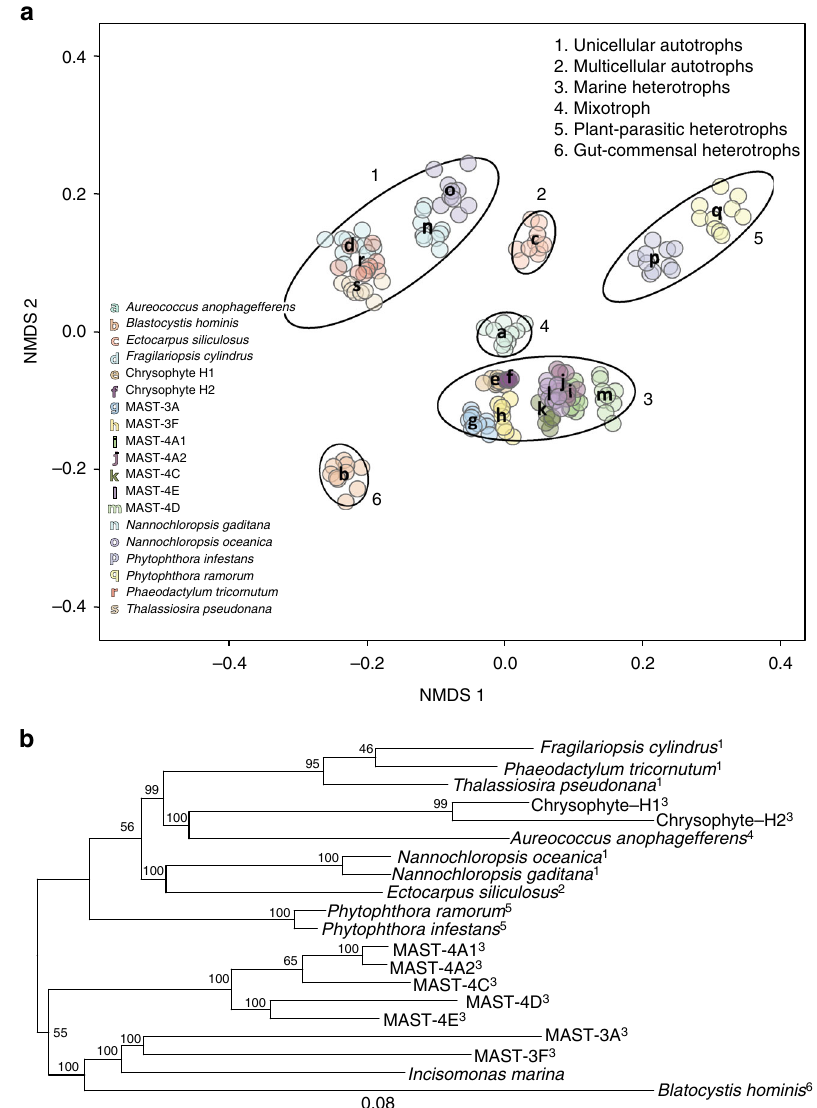
Fig. 1 Marine heterotrophic SAG lineages form a functional group distinct from autotrophs and other heterotrophs. a Non-metric multidimensional scaling (NMDS) projection of a Bray – Curtis distance matrix that shows Pfam motif occurrences in various stramenopile genomes. Because the genome sequences are incomplete, a rarefying procedure was applied to obtain 1400 Pfam motifs per genome. Ten independent rare fi ed samples were obtained and used for NMDS. Ellipses (at 95% con fi dence limit) were drawn by using the ‘ ordiellipse ’ function of the vegan package in R, with the group de fi ned by life history mode (indicated by number in top right). Letters indicate the positions of the mean coordinates of the 10 rare fi ed Pfam counts per organism. The analysis was conducted on 19 stramenopile genomes, which included MAST-4D 8 . Marine heterotrophic stramenopiles from this study form a large but coherent group (Group 3), which is distinct from autotrophic species and heterotrophic species from other environments. b Phylogenetic tree from the analysis of a total of 160 conserved eukaryotic proteins using maximum likelihood. Protein sequences of Incisomonas marina from ref. 44 are included. Indices indicate life history mode as in panel a . Bootstrap values are represented on internal nodes. The branch length represents the mean number of substitutions per